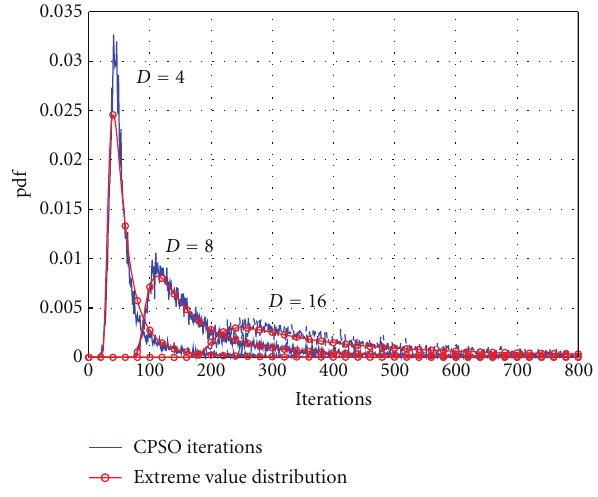
Figure 5: Histogram of the minimum number of iterations required to converge in dependence of the